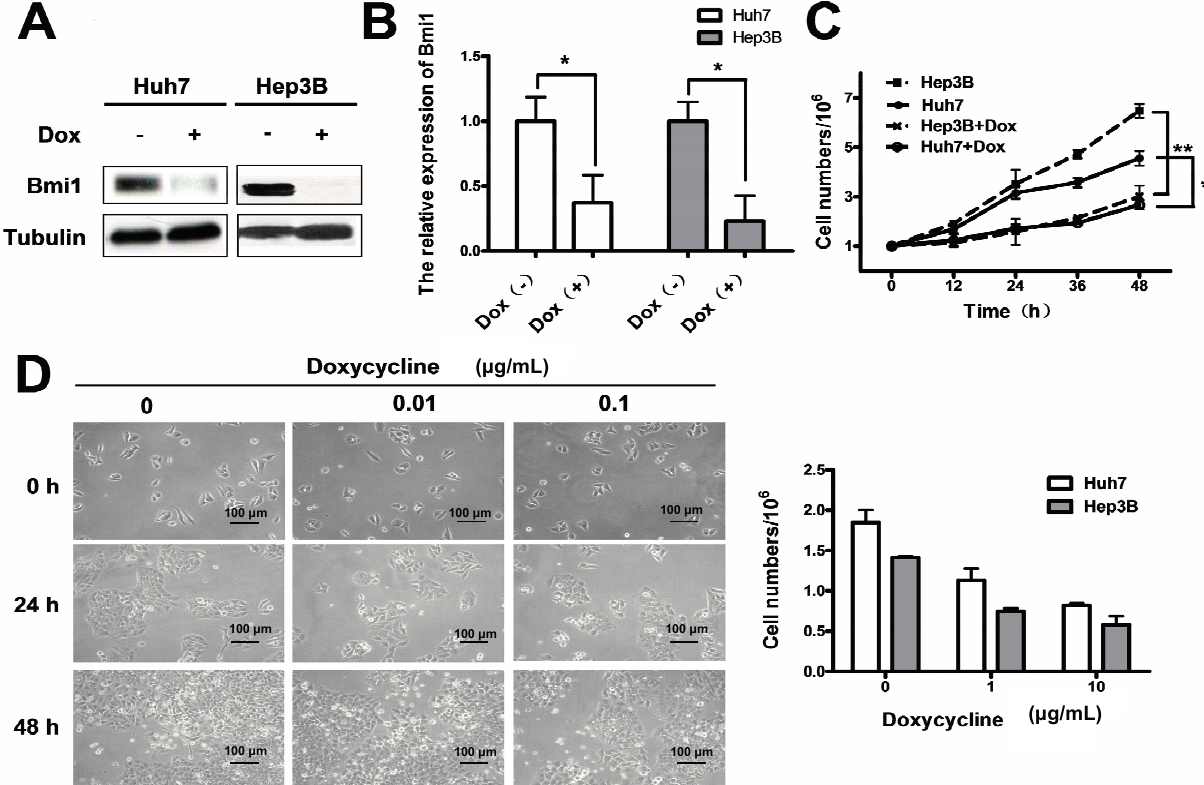
Figure 4. Conditional knockdown of Bmi1 by the tet-on system inhibits the HCC cell growth in vitro. Hep3B and Huh7 cells were infected with lentivirus carrying inducible Bmi1 shRNA. After 48 h of puromycin selection, 0.1 μ g/mL of doxycycline was added in the culture medium to activate the Bmi1 shRNA expression. After 48 h of doxycycline treatment, the cells were processed for western blot, qRT-PCR and proliferation assays. ( A ) Western blotting of Bmi1 in the Hep3B and Huh7 cells transfected with Bmi1 shRNA lentivirus. Hep3B and Huh7 cells were infected with lentivirus carrying inducible Bmi1 shRNA, and 0.1 μ g/mL of doxycycline were added in the culture medium to activate the Bmi1 shRNA expression; ( B ) qRT-PCR results of the Bmi1 mRNA level in Huh7 and Hep3B cells transfected with Bmi1 shRNA by pLKO-Tet-On lentivirus; ( C ) The growth curves of Huh7 and Hep3B cells when the Bmi1 gene was knocked down. Cells were cultured in medium with 0.1 μ g/mL of doxycycline after infecting with lentivirus, and cell numbers were counted at different time points after trypsin digestion; and ( D ) Cell growth of Huh7 and Hep3B cells treated with different concentrations of doxycycline. The morphology of Hep3B cells treated with doxycycline is shown on the left. The Huh7 and Hep3B cell numbers were counted after 1 × 10 5 cells were cultured in six-well plates for 48 h. Data are expressed as the mean ± SD. * p < 0.05, and ** p < 0.01.